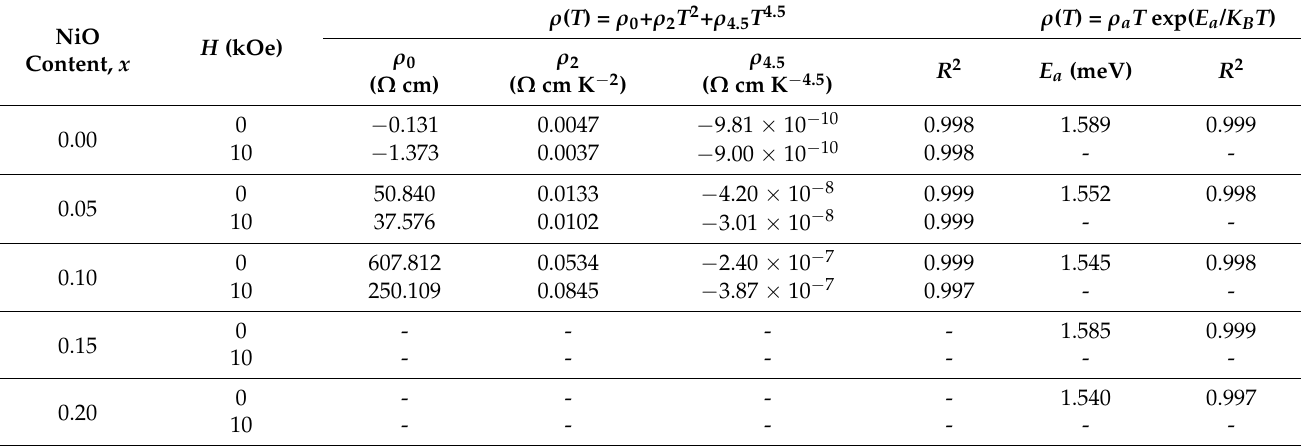
Table 3. Parameters obtained corresponding to the best fit of the experimental data based on Equations (2) and (3) for (1 − x ) LCMO: x NiO ( x = 0.00, 0.05, 0.10, 0.15 and